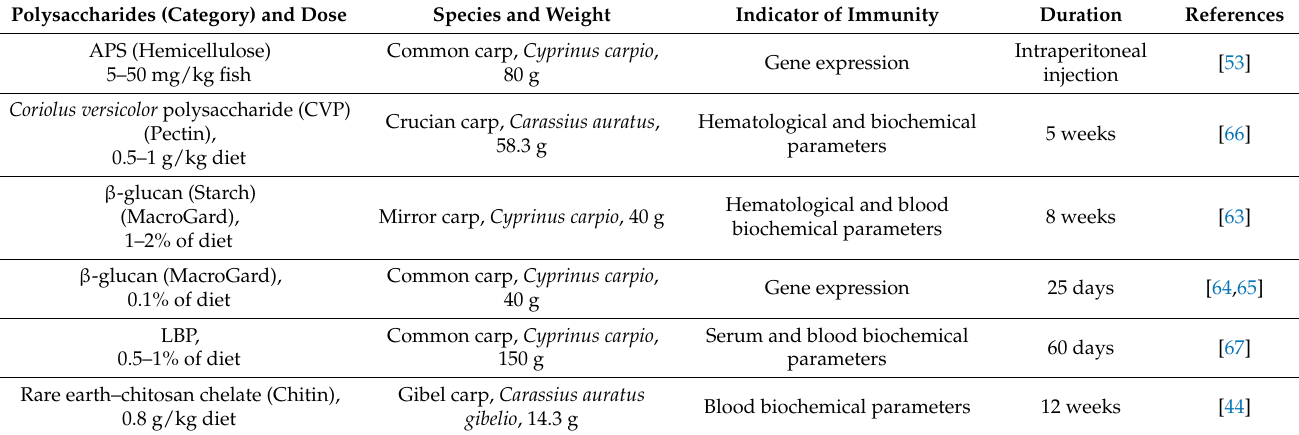
Table 2. The role of polysaccharides in activating the innate immunity of